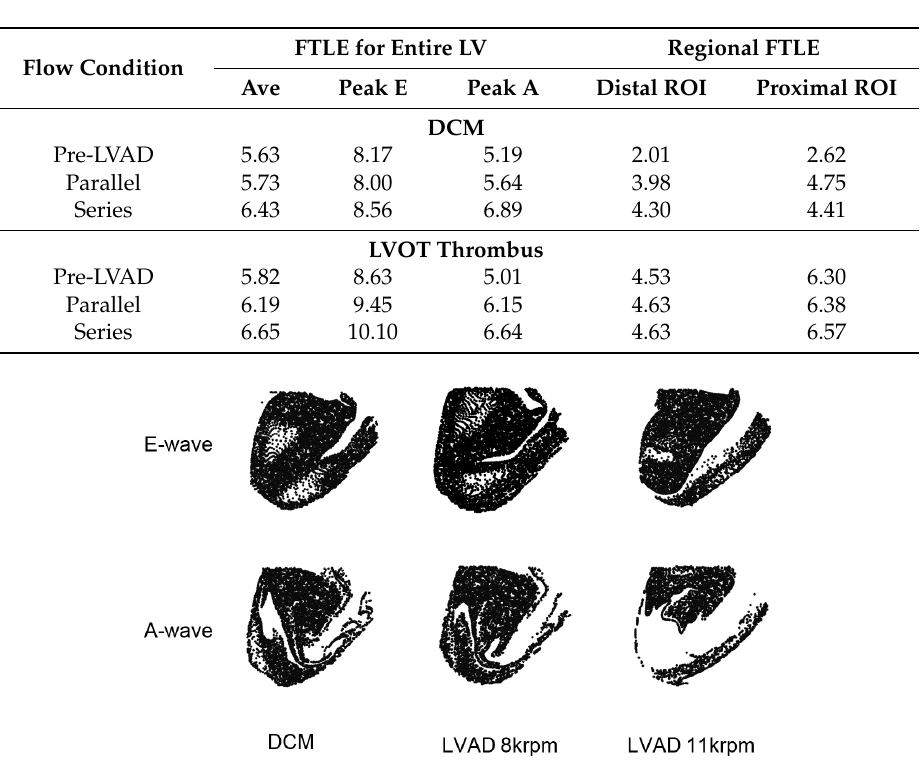
Figure 5. Lagrangian particle analysis reflects the LCS structures identified from the FTLE analysis, illustrating how the altered filling dynamics affects transport through the LV.